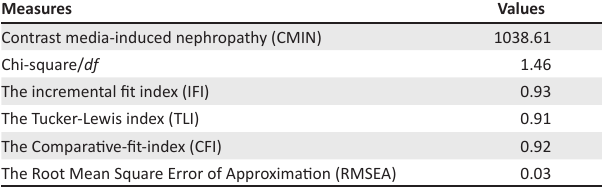
TABLE 5: Structural equation modelling model fit indices results. Measures